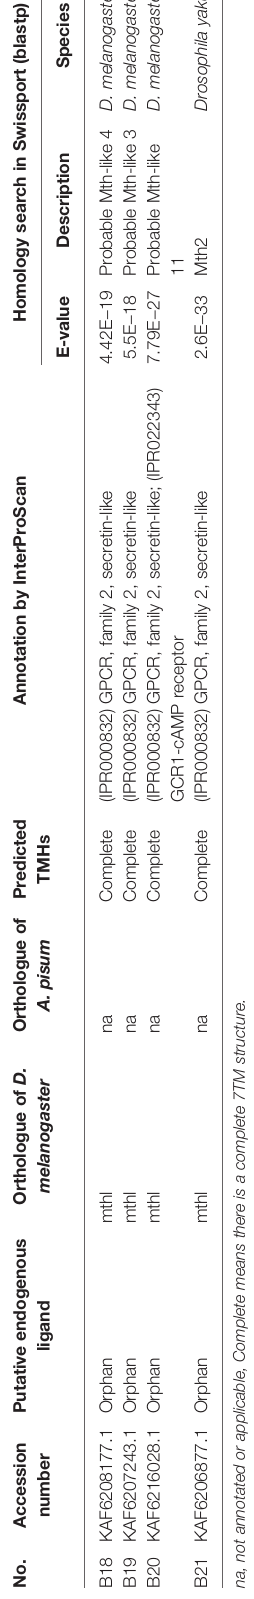
TABLE 4 | The number of A. lucorum GPCRs of each family in comparison with the other four